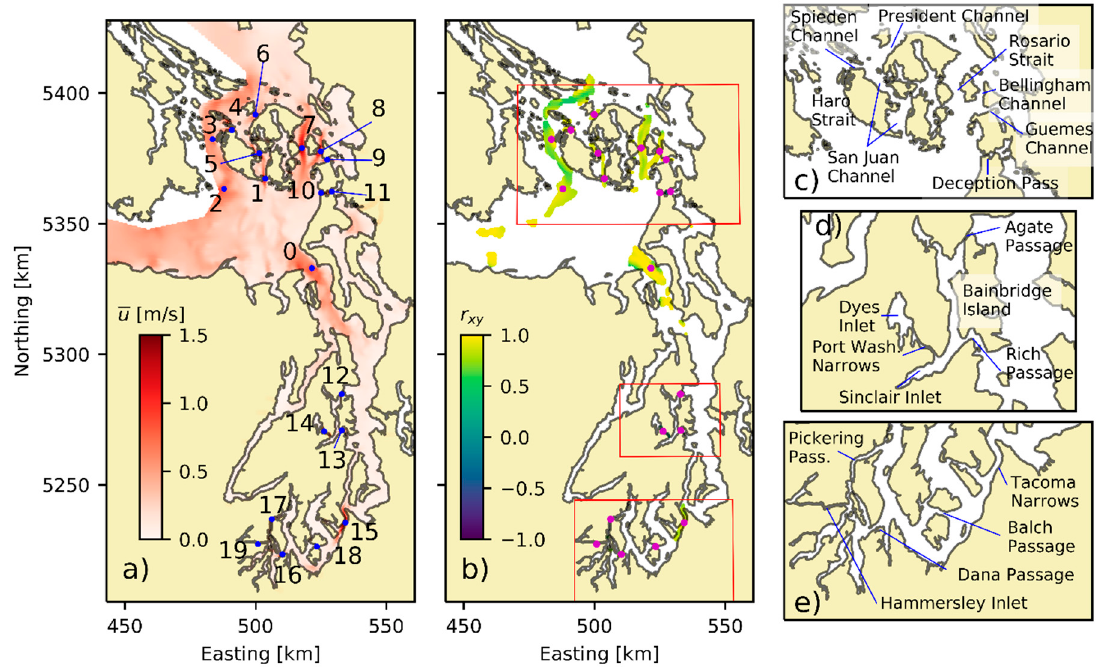
Figure 1. Salish Sea study area. ( a ) Mean tidal current speed and ( b ) cross-correlation at points with a mean velocity above 50 cm / s with respect to the anchor point (0). Representative points for the correlation analysis are identified. Points identified are (0) Admiralty Inlet, (1) San Juan Channel South, (2) Haro Strait South, (3) Haro Strait North, (4) Spieden Channel, (5) San Juan Channel, (6) President Channel, (7) Rosario Strait, (8) Bellingham Channel, (9) Guemes Channel, (10) Deception Pass West, (11) Deception Pass East, (12) Agate Passage, (13) Rich Passage, (14) Port